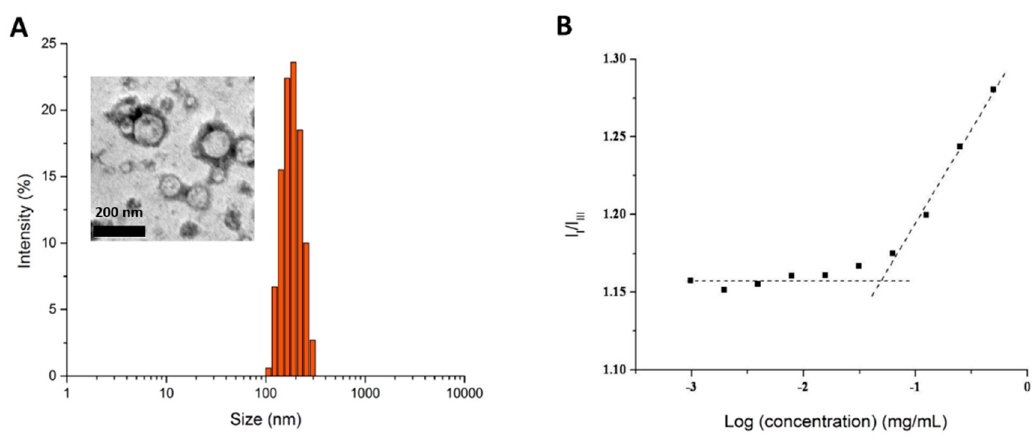
Figure 5. ( A ) Particle size distribution, and ( B ) plot of the intensity ratio (I I /I III ) versus concentration of 5’-DFUR-PCL-MPEG micelles. Inset represents a TEM image. Scale bar denotes 200 nm.